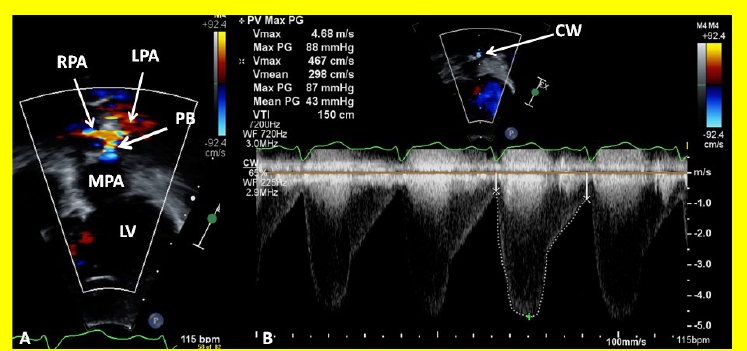
Figure 22. Selected echocardiographic video frames demonstrating pulmonary artery band (PAB) with narrow diameter of 2.9 mm by 2D ( A ) and by color flow ( B ) and a high gradient (81 mmHg) by continuous wave Doppler ( C ) are shown.